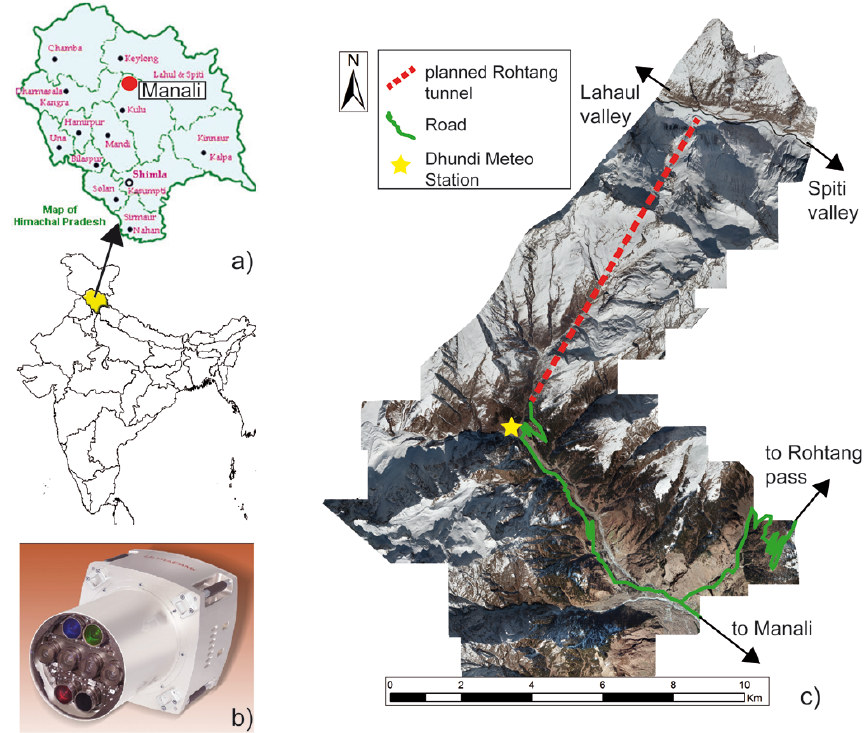
Fig. 3. (a) Test site Manali, Himachal Pradesh, India, (b) image of the large-format digital photogrammetry camera ULTRACAMx (Gruber et al., 2008) and (c) 7 December 2009 image of the study